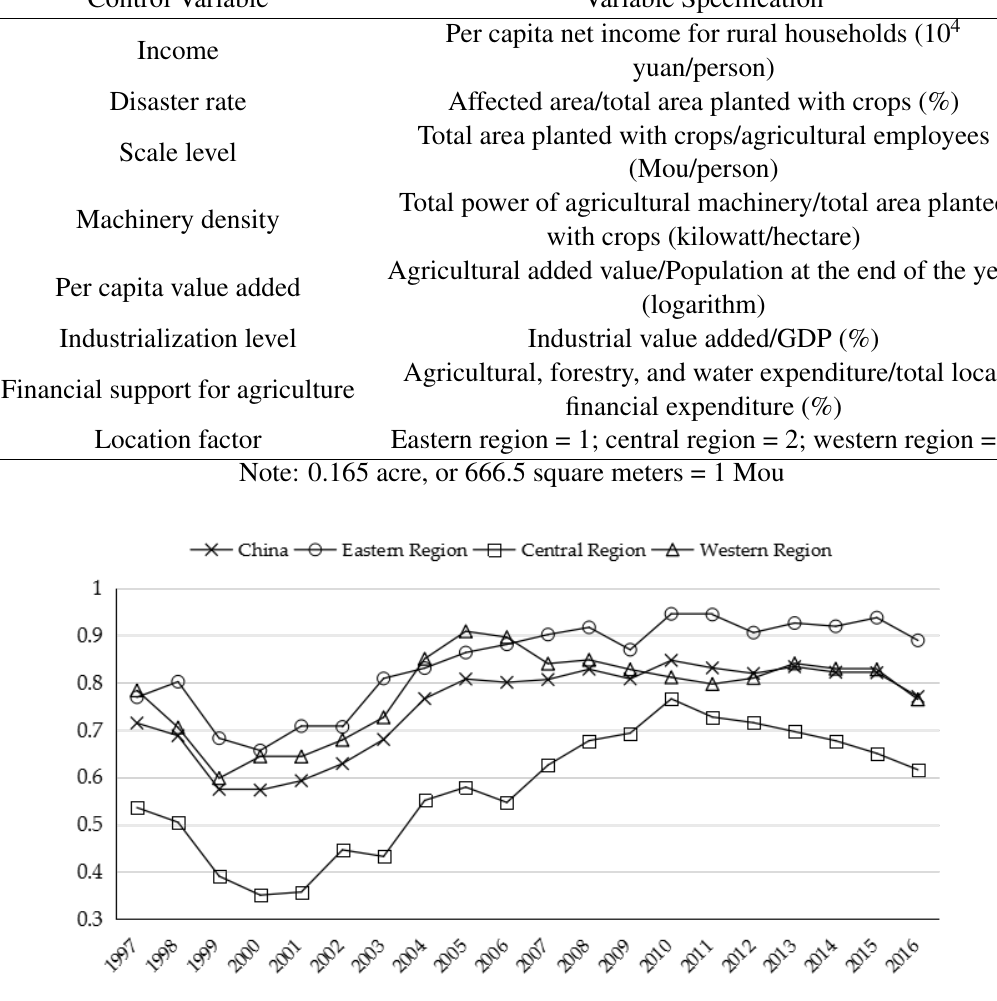
western regions were roughly the same as that in the whole country. The agricultural GTFP in the central